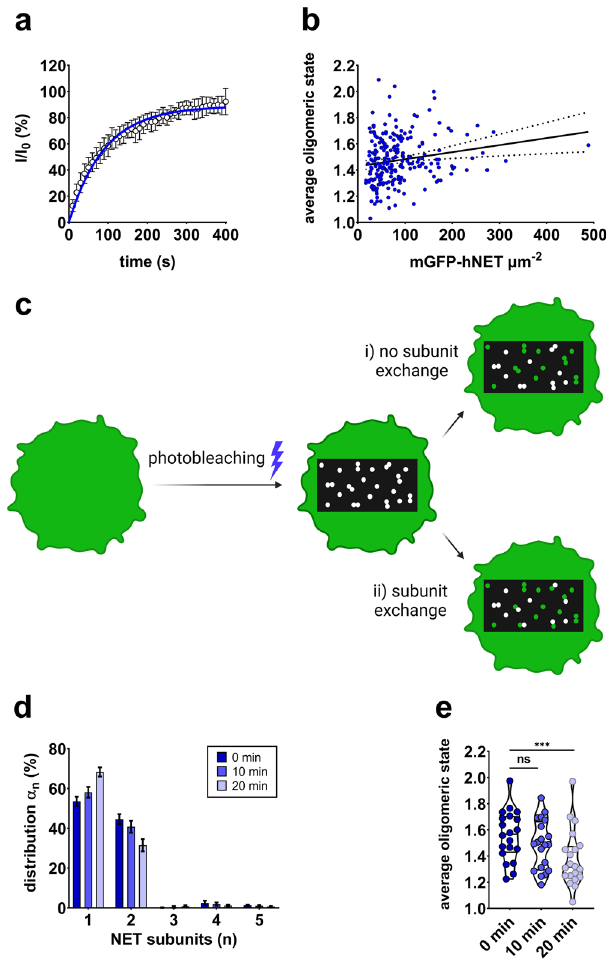
Fig. 2 Mobile fraction, distribution, and stability of NET subunits. a Mobile fraction of NET determined by FRAP microscopy. Data points represent averages of ten cells (± SD), which were fi tted by a one-phase association curve (Equ. 1). b NET oligomerization displays a slight transporter density-dependent behavior. Densities of 261 cells measured under control conditions were plotted against the average oligomeric state, resulting in a signi fi cant correlation (Spearman r: 0.1898, P < 0.01). c Sketch showing two potential scenarios. i) Scenario 1: dimers are stable; repeated runs result in a decreased number of active fl uorophores but no altered distribution. ii) Scenario 2: dimers exchange subunits; the exchange of bleached (white) and unbleached (green) dimers results in an increasing fraction of apparent monomers. d Repeated TOCCSL runs on the same cell indicate that a small portion of NET dimers exchange subunits over time. A total of 20 cells were repeatedly measured three times over the course of 20 min. Data show means ± SD. e Average oligomeric state of NET molecules for each of the repeatedly measured